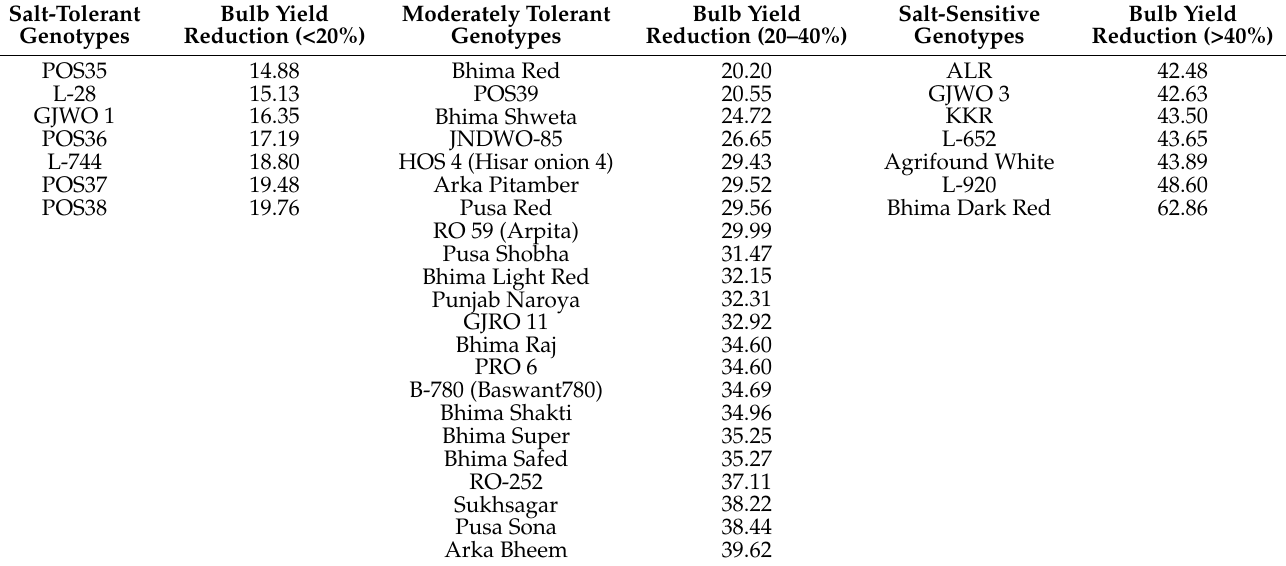
Table 4. Grouping of onion accessions on % bulb yield reduction in saline environment. Salt-Tolerant